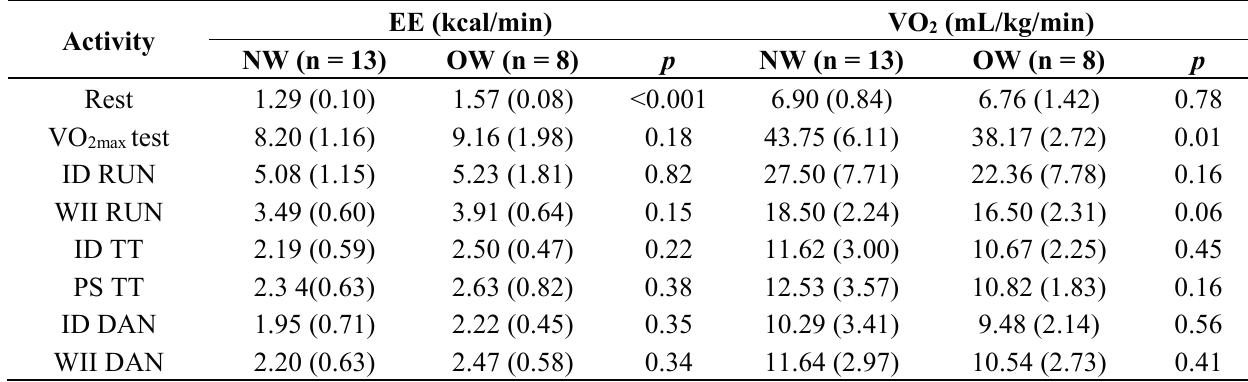
Table 3. Energy expenditure and VO 2 by weight status for each condition.